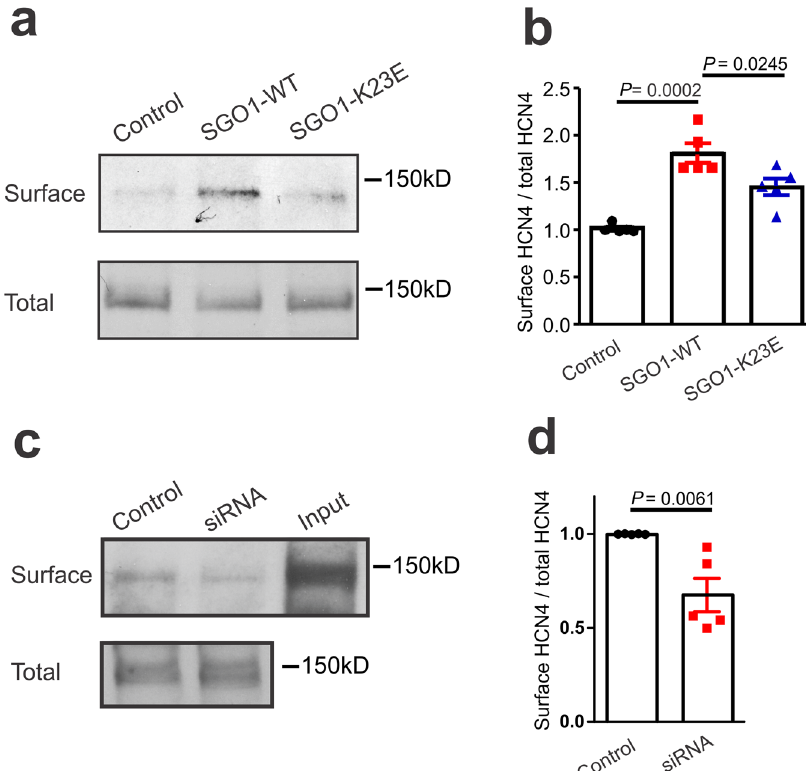
Fig. 5 Effect of SGO1-WT and SGO1-K23E on HCN4 surface expression in NRVMs. a SGO1-WT and SGO1-K23E were transduced into NRVMs 2 days before surface labeling with biotin probe. The surface and total expression of HCN4 was tested by Western blot. b Quantitation of HCN4 surface expression in a . n = 5 biologically independent preparations exposed to all conditions. Data are expressed as mean ± SEM, normalized to respective control sample result for each preparation. One-way ANOVA with Tukey ’ s multiple comparison test. c The surface and total expression level of HCN4 were tested after 2 days of siRNA and control scrambled RNA transduction. NRVMs lysates were loaded as input control. d Quantitation of HCN4 surface expression in c . n = 5 biologically independent preparations exposed to both conditions. Data are mean ± SEM, normalized to respective control sample result for each preparation. Unpaired two-tailed Student ’ s t